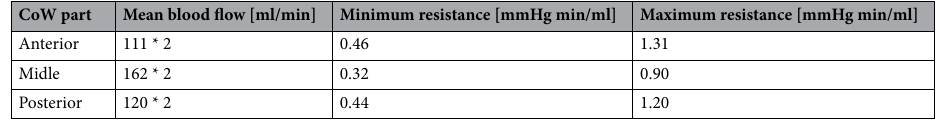
Table 4. Autoregulation model